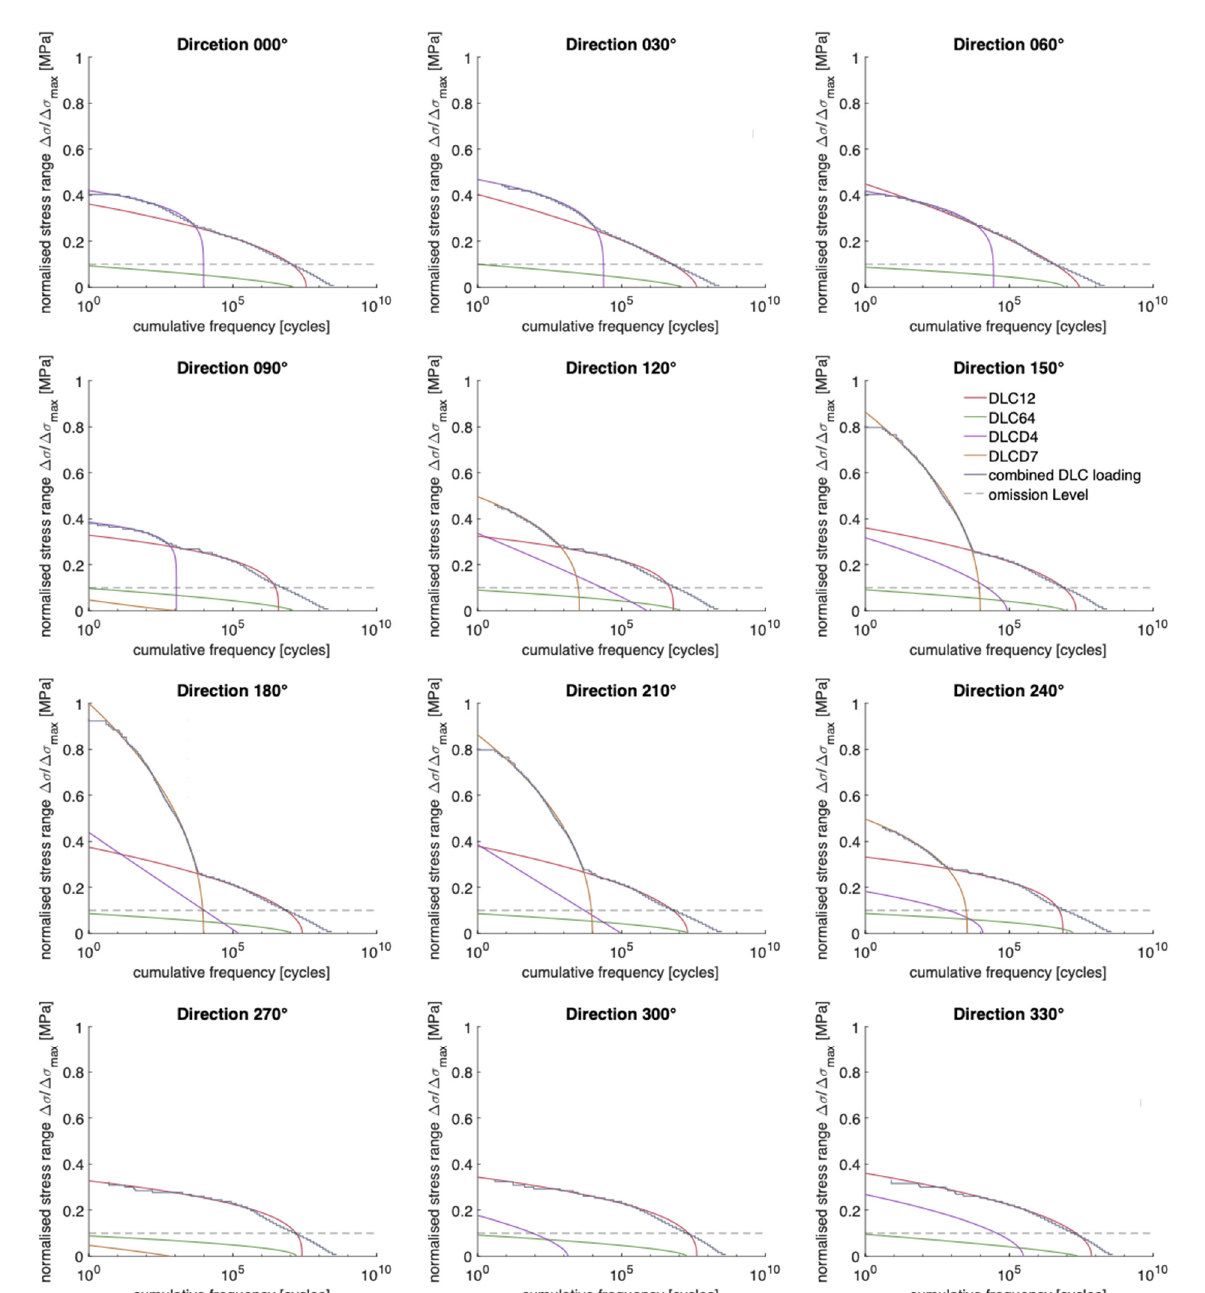
Figure 6. Derived load spectra for different sectors around the circumference of the monopile support structure including fitted Weibull distributions for the four DLCs and an estimated service life of 23.27 years (about 23 years and 3 months).